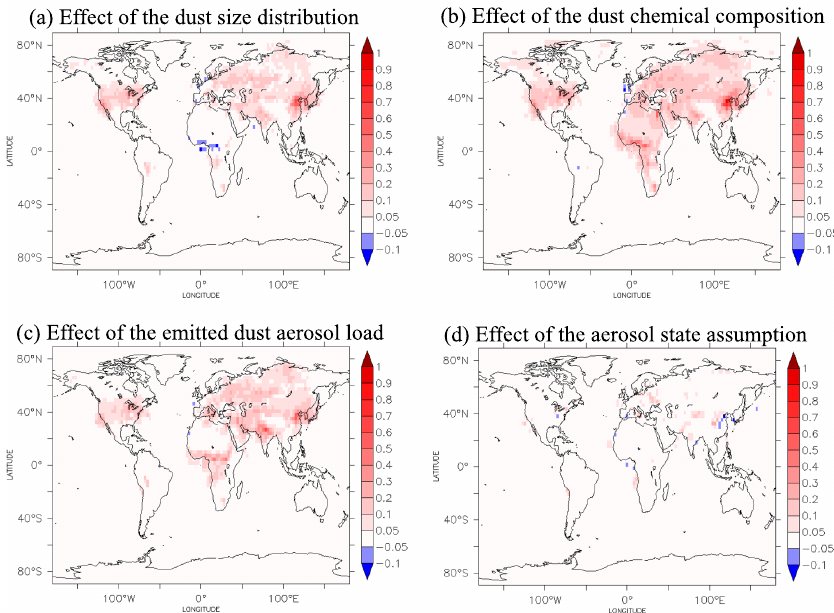
Figure 7. Absolute changes (in µgm − 3 ) of the predicted average near-surface aerosol nitrate after (a) using a dust emission parameterization scheme that utilizes a homogeneous global soil size distribution of dust particles, (b) assuming a global uniform chemical composition of mineral dust, (c) a 50% reduction of mineral dust emissions, and (d) assuming a metastable state for aerosols, during the years 2005–2008. A positive change corresponds to a decrease in the sensitivity